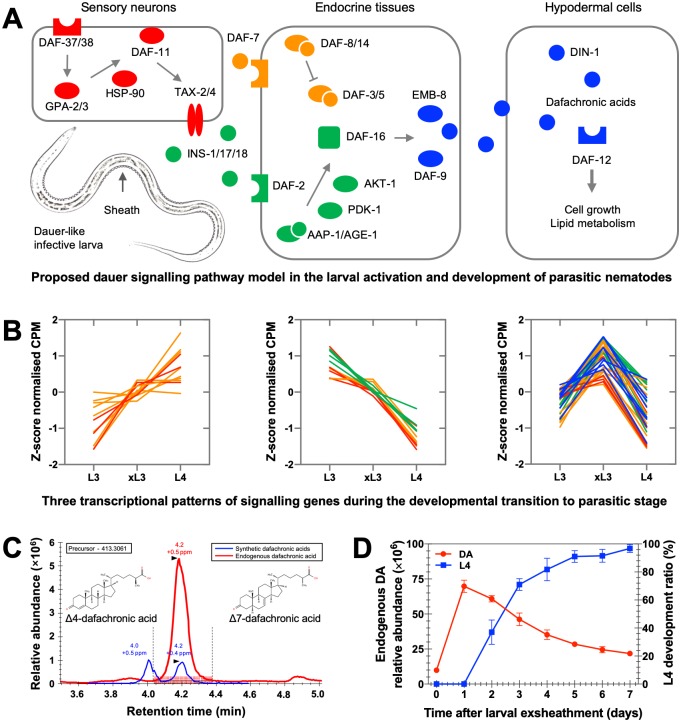
Transcriptional changes pertaining to dauer signalling genes, and quantification of dafachronic acids in Haemonchus contortus during developmental transition.(A) Model of the cyclic guanosine monophosphate (cGMP) (red), DAF-7-related transforming growth factor-β (TGF-β) (orange), DAF-2-related insulin-like growth factor 1 (IGF-1) (green) and steroid hormone signalling (blue) pathways proposed for H. contortus [34]. This model is predicted to play a role in integrating environmental signals to control the biosynthesis of one or more dafachronic acids (DAs), which activate the nuclear hormone receptor DAF-12. The DA-DAF-12 module might serve as a checkpoint for developmental decisions and associate with nutrient metabolism in parasitic nematodes [8,14,17,34]. (B) Transcriptional profiles (Z-score normalised, mapped reads per million) of 61 gene homologues involved in the cGMP (red), TGF-β (orange), IGF-1 (green) and steroid hormone (blue) signalling pathways are displayed for the developmental transition from the dauer-like third larval stage (L3), via exsheathed L3 (xL3), to the parasitic fourth larval stage (L4) of H. contortus in vitro. (C) Using (25S)-Δ4-DA (calculated mass: 413.3061, retention time: 4.0 min) and (25S)-Δ7-DA (calculated mass: 413.3061; retention time: 4.2 min) as references (blue peaks), endogenous Δ7-DA (retention time: 4.2 min; red peak) was detected in H. contortus with mass error estimated at 0.5 part per million (ppm). (D) The relative abundance of endogenous Δ7-DA following larval exsheathment and in the ensuing larval development in vitro is indicated.